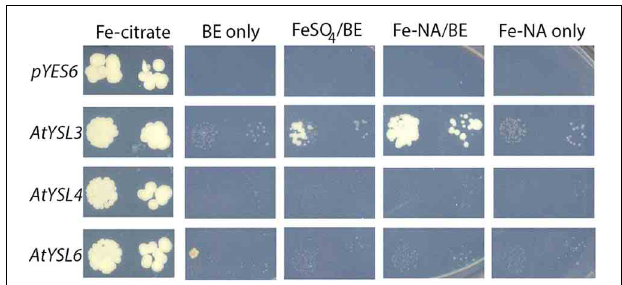
FIGURE 14 | Neither AtYSL4 nor AtYSL6 is able to complement fet3fet4 . These experiments were performed as described (Chu et al. 2010). fet3fet4 yeast (derived from DEY1453) transformed with pGEV and pYES6/CT empty vector (top row) or constructs containing AtYSL3 (middle row), AtYSL4 (third row), and AtYSL6 (bottom row) were plated onto SD-TRP medium containing 50mM Fe-Citrate (first column), 0mM iron + 10nM beta-estradiol (BE) (second column), 5mM FeSO4 + 10nM BE (third column), 5mM Fe-NA complex + 10nM BE (fourth column), or 5mM Fe-NA complex without BE (last column). Pairs of spots correspond to 100 and 1000 fold dilutions of the original cultures. Plates were photographed after 10 days of